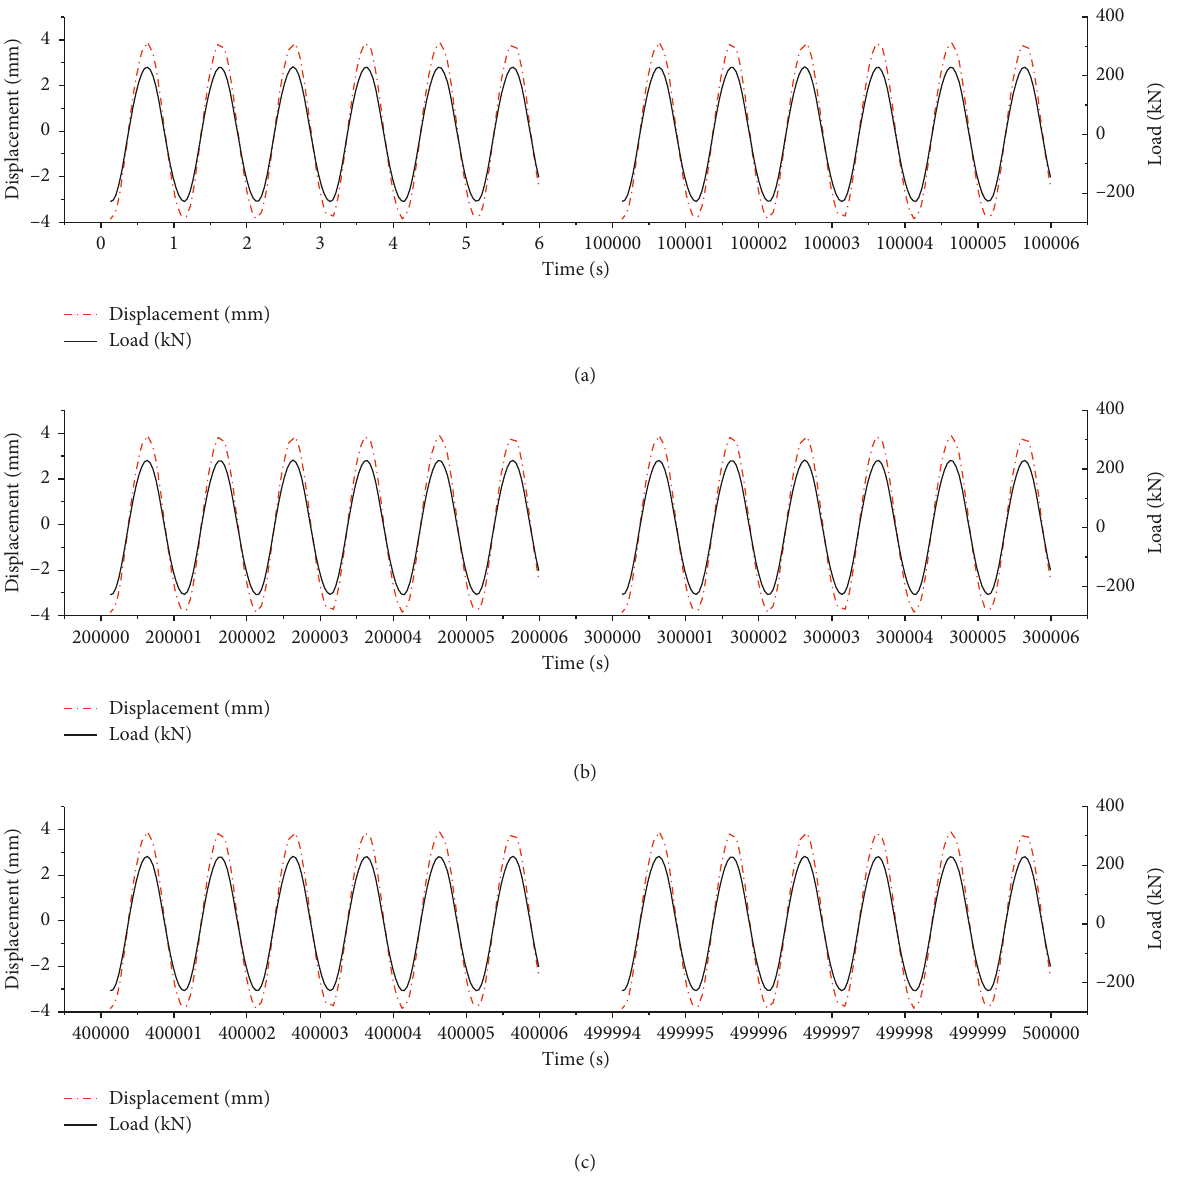
Figure 4: Analysis of the GZ-6 load-displacement-time